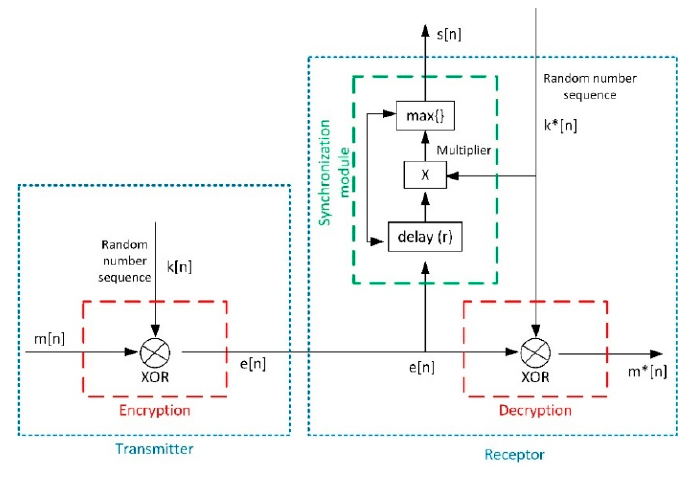
Figure 2. Encryption scheme.